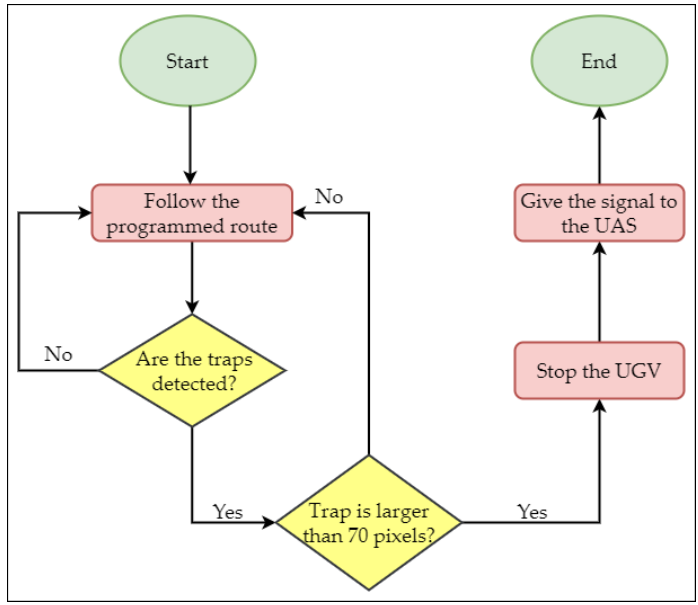
Figure 6. Flowchart of the UGV